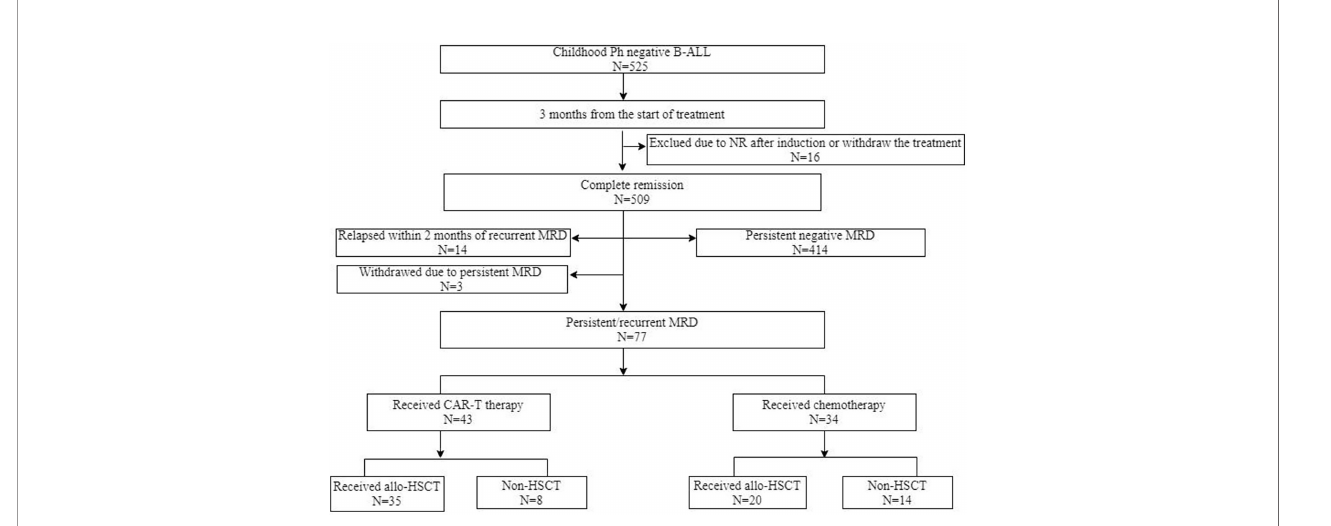
FIGURE 1 | Diagram of patients enrolled in this study. CAR-T, chimeric antigen receptor T cells; ALL, acute lymphoblastic leukemia; allo-HSCT, allogeneric haematopoietic stem cell transplantation; MRD, measurable residual disease; NR, non-remission; Ph, Philadelphia